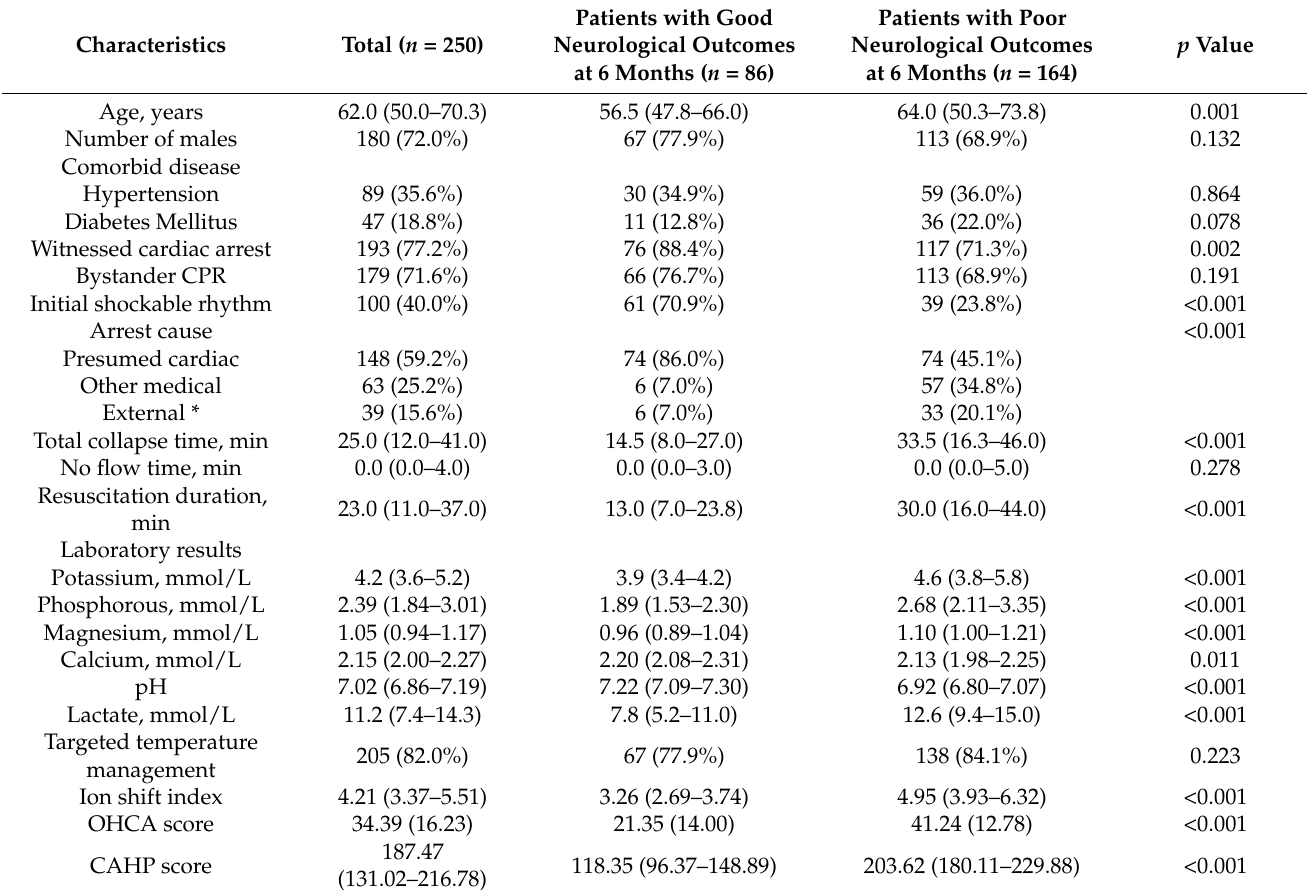
Table 1. Demographic and clinical characteristics of the patients with out-of-hospital cardiac